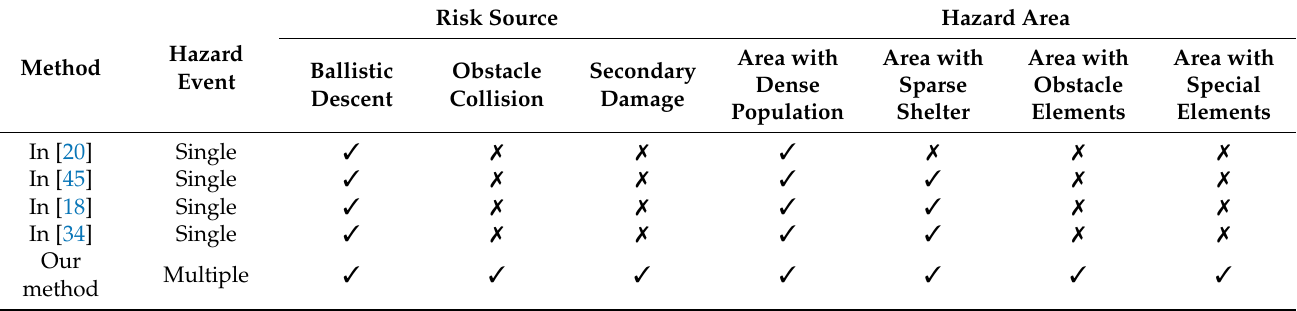
Table 1. Comparison